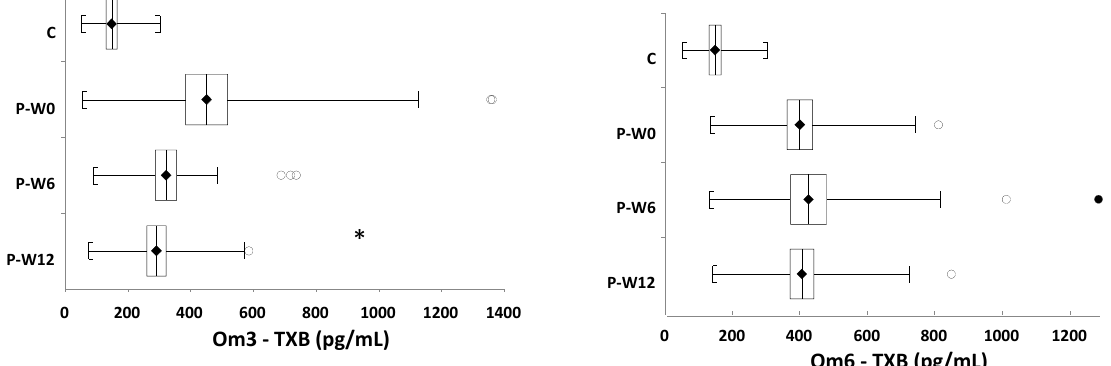
Figure 2. The levels of TXB in healthy controls and in patients with depressive disorder, during the intervention. C = controls, P = patients, Om3 = omega-3 patient intervention group, Om6 = omega-6 patient intervention group, TXB = thromboxane B, W = week of the intervention; • outer fence for outlier, ◦ inner fence for outlier, * p < 0.05 with respect to W0.